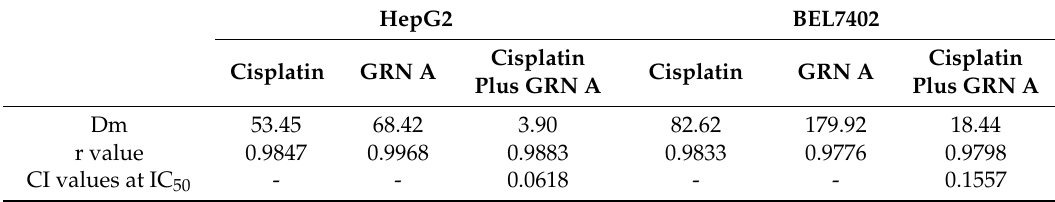
Table 2. The dose-effect relationship parameters and combination index (CI) values of cisplatin, GRN A, and the combination of cisplatin and GRN